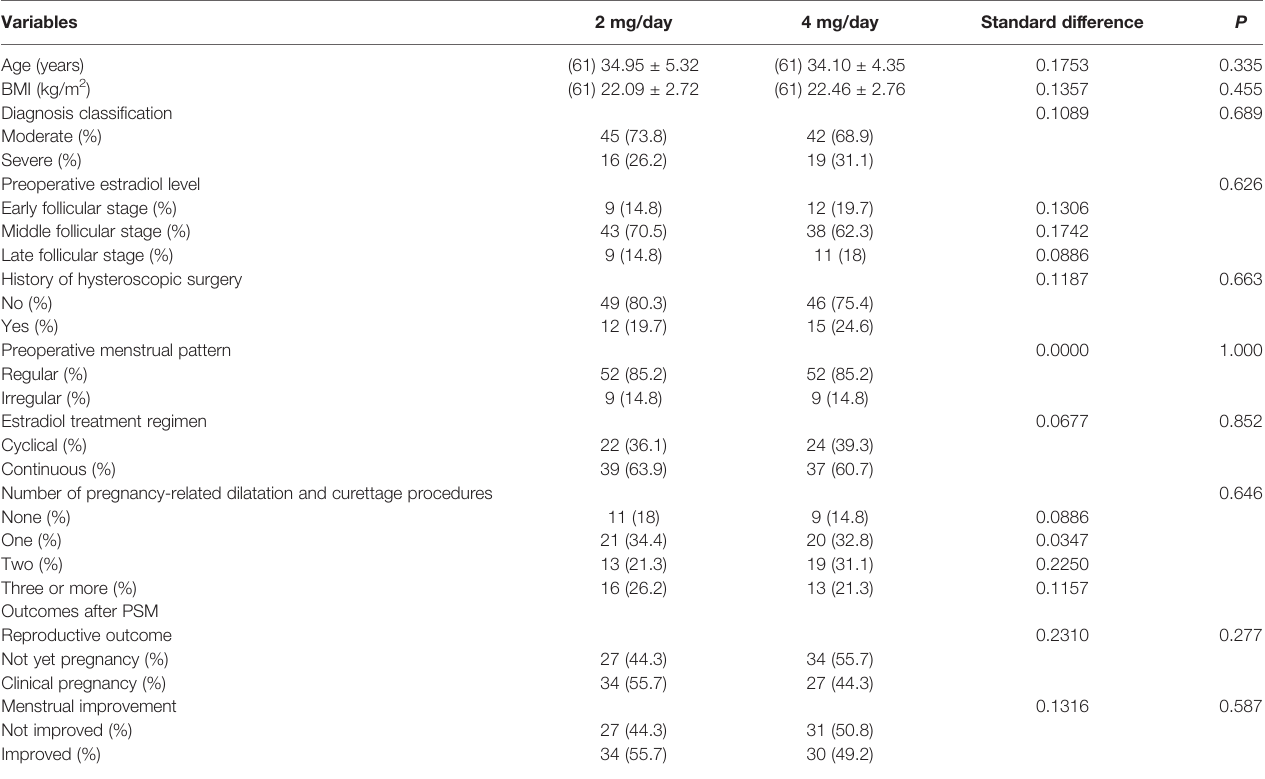
TABLE 3 | Characteristics of the propensity-matched groups.